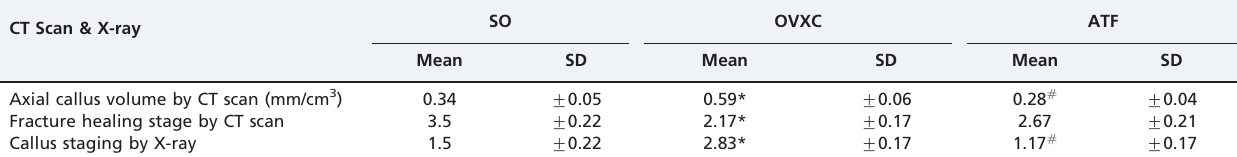
Table 2 - The axial callus volume measured and calculated using CT scan, fracture healing stage based on radiological scoring assessed from X-ray images, and callus staging scores based on radiological scoring assessed from X-ray images. CT Scan & X-ray SO OVXC